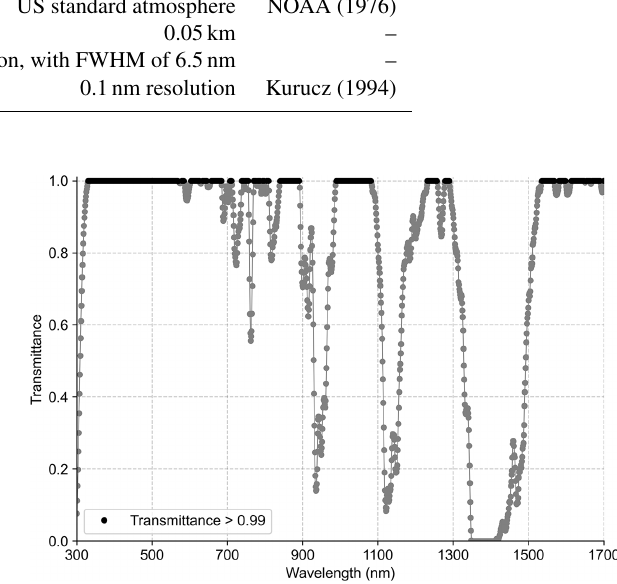
Figure 6. The transmittance without Rayleigh scattering and con- tinuous water vapor absorption in the EKO band, where the trans- mittance values greater than 0.99 are marked in black, and the rest are marked in